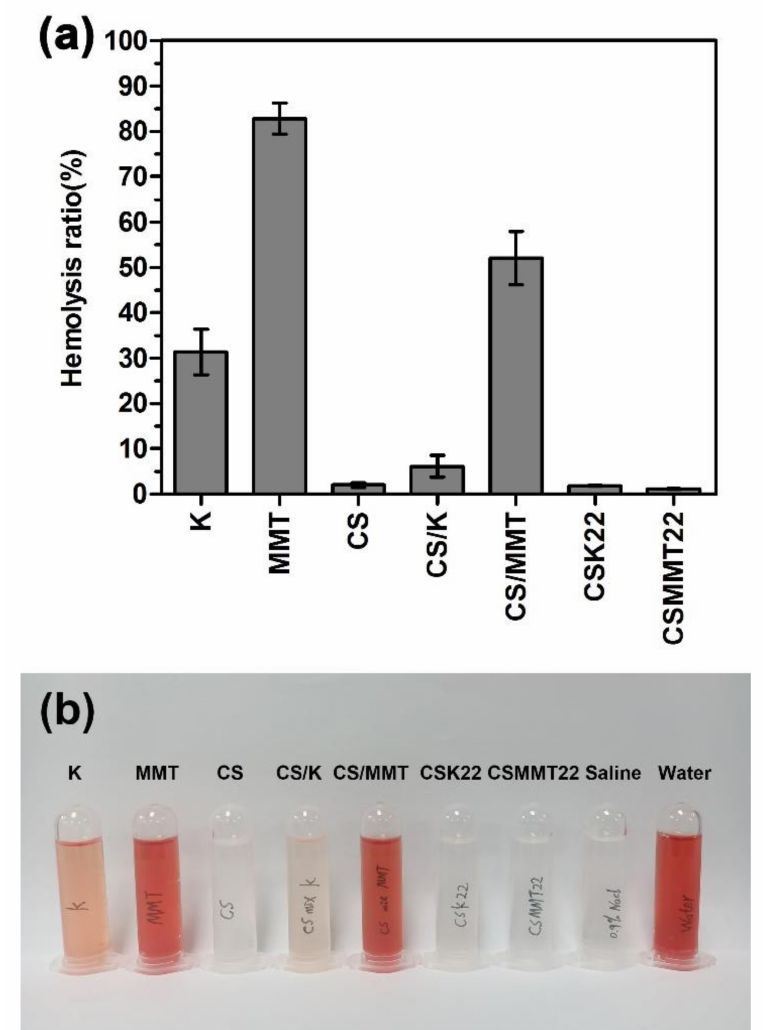
Figure 9. ( a ) Hemolysis rates of K, MMT, CS, CS/K, CS/MMT, CSK22, and CSMMT22. Data represent the mean ± SD ( n = 3). ( b ) Photograph of RBCs treated with K, MMT, CS, CS/K, CS/MMT, CSK22, CSMMT22, saline, and water,